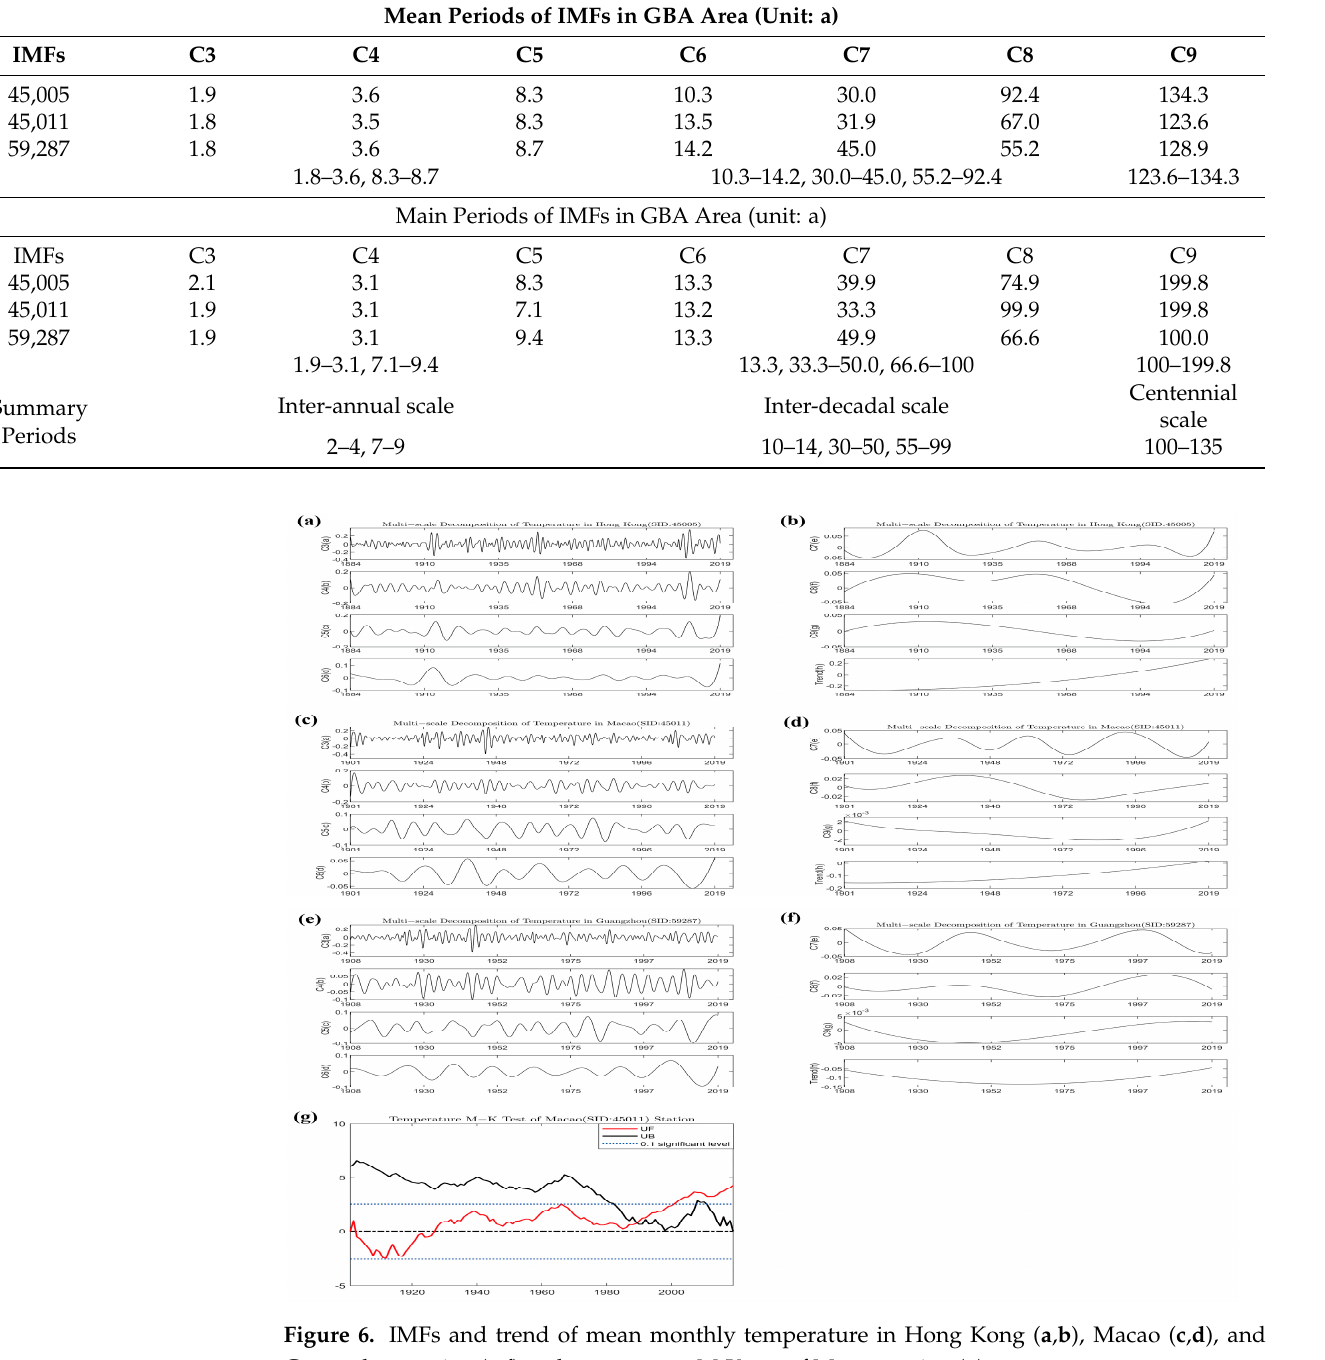
Table 6. Multi-scale periodic analysis of temperature in The Guangdong–Hong Kong–Macao Greater Bay (GBA).